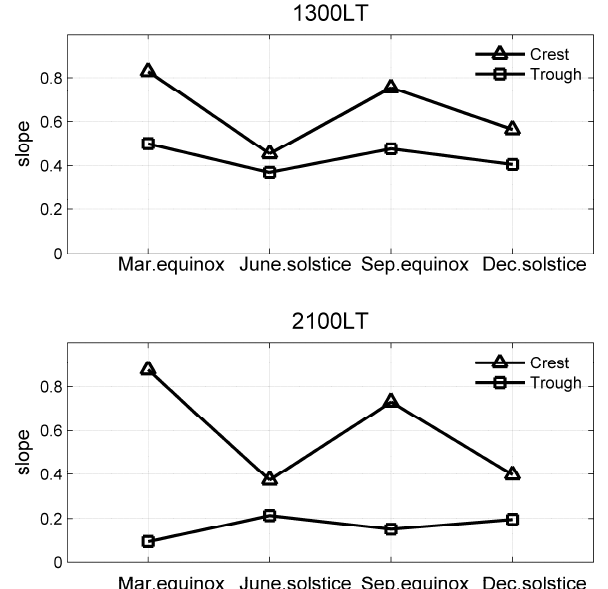
Fig. 7. Slopes of the solar activity dependence of TEC in different Figure 7 . Slopes of the solar activity dependence of TEC in different seasons in the EIA crest seasons in the EIA crest and trough regions for noon and post-sunset and trough regions for noon and post-sunset sectors. Slopes are obtained by least squares sectors. Slopes are obtained by least squares fitting of data points fitting of data points for F 10.7 <200 shown in Figure 6. for F 10 . 7 < 200 shown in Fig.